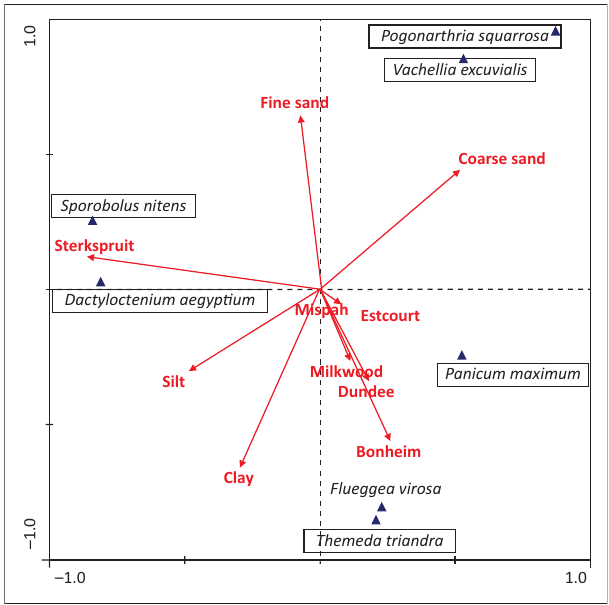
FIGURE 5: Simple ordination diagram of the canonical correspondence analysis (first and third axes) showing the relationships between selected species’ cover abundance and soil chemical properties. The eigenvalues of the respective axes were 0.659 for axis 1 and 0.100 for axis